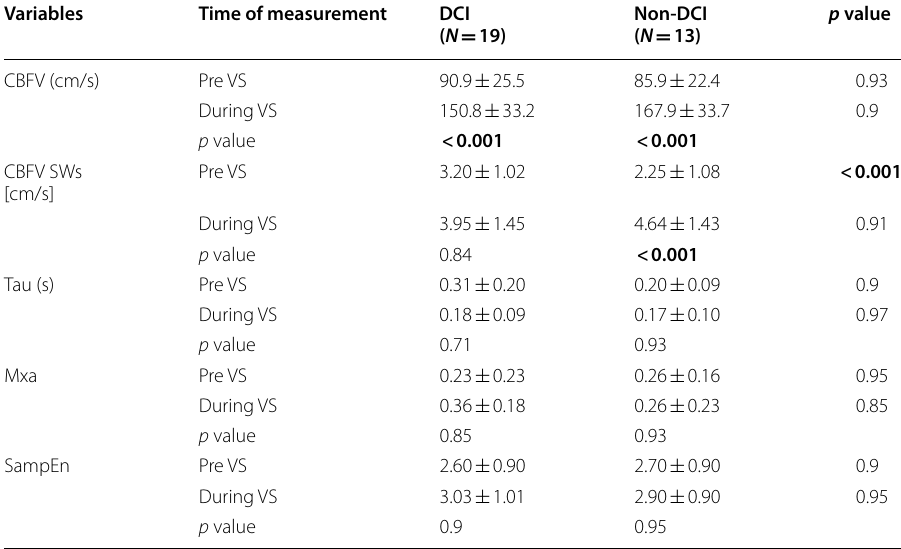
Table 3 Temporal differences of measured variables ipsilateral to VS side, between and within groups (two-way mixed-design ANOVA, post hoc comparisons, SPSS Sidak adjusted p values)